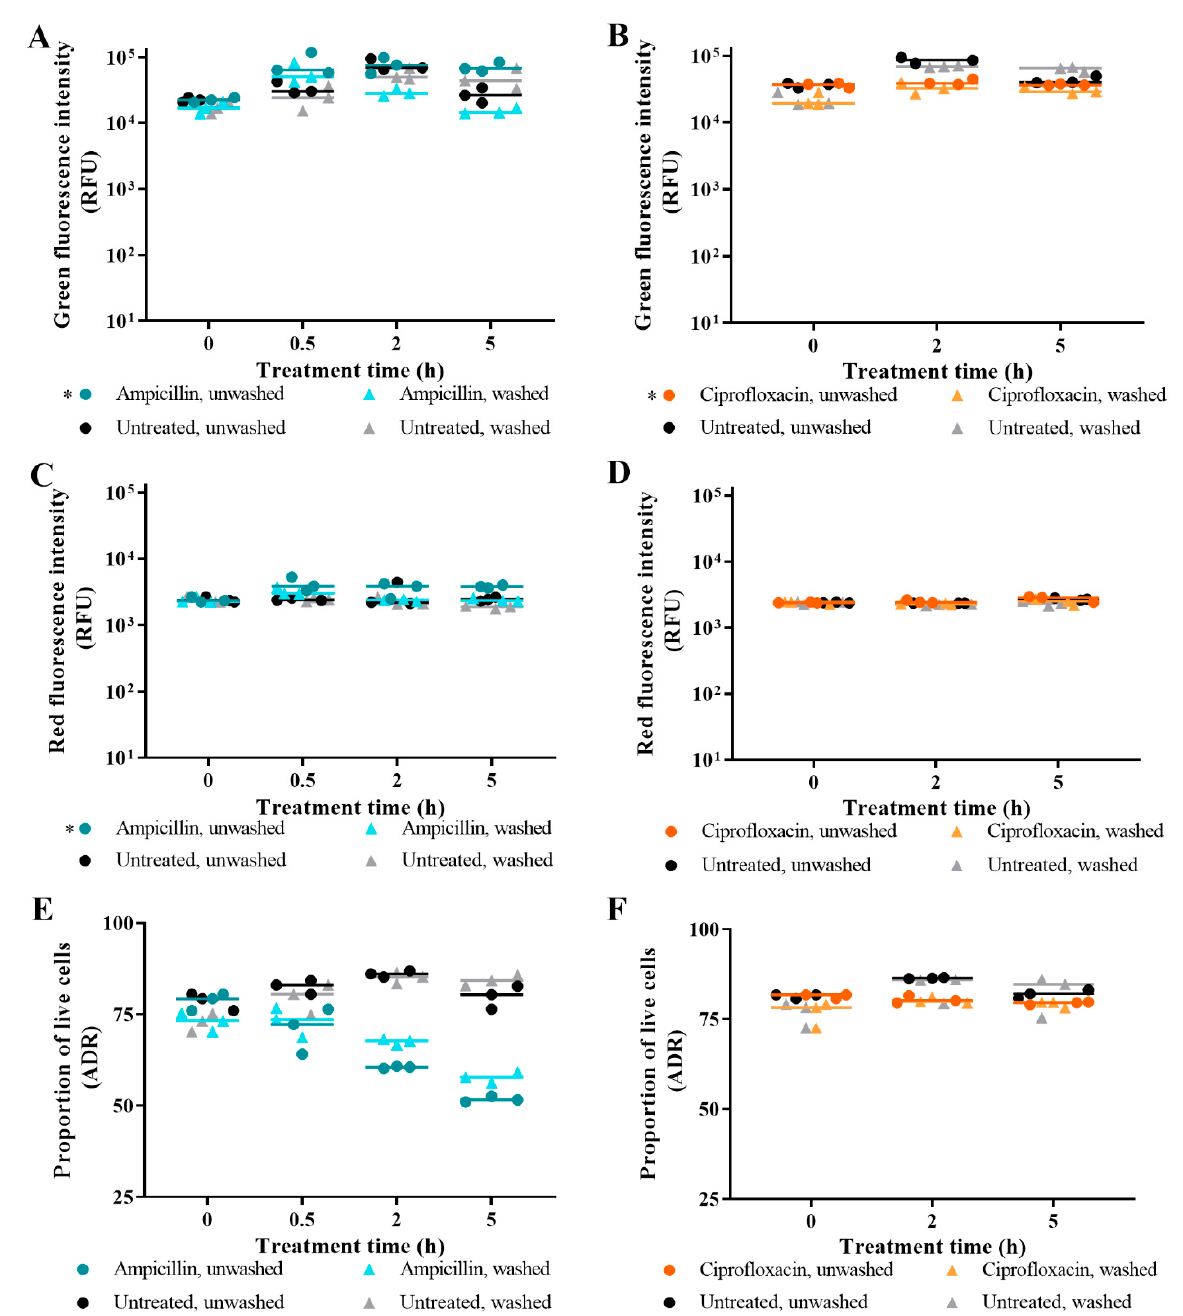
Figure 1. The impact of pre-staining washing of antibiotic-challenged E. coli . The effect of washing aliquots before staining is presented for SYTO 9-stained cells ( A , B ); PI-stained cells ( C , D ); and SYTO 9- and PI-stained cells ( E , F ). E. coli was challenged with ampicillin (teal/cyan), ciprofloxacin (orange), or nothing (untreated; black/grey), and samples were taken at 0 h (pre-treatment), 0.5 h (ampicillin only), 2 h, and 5 h. Before staining of duplicate aliquots with SYTO 9 and/or PI, one aliquot was left unwashed while the other aliquot was washed in fresh MM. Fluorescence intensities were obtained from integrating 505–515 nm for green emissions and 600–610 nm for red emissions. The adjusted dye ratio (ADR) was calculated using the green and red emissions from SYTO 9- and PI-stained samples to indicate the proportion of live cells in the aliquot. Each dot represents a biological replicate, and the median is shown by the line. Statistical significance between washed and unwashed samples is represented by * (two-way RM ANOVA, p value < 0.05, Tukey multiple comparisons test).